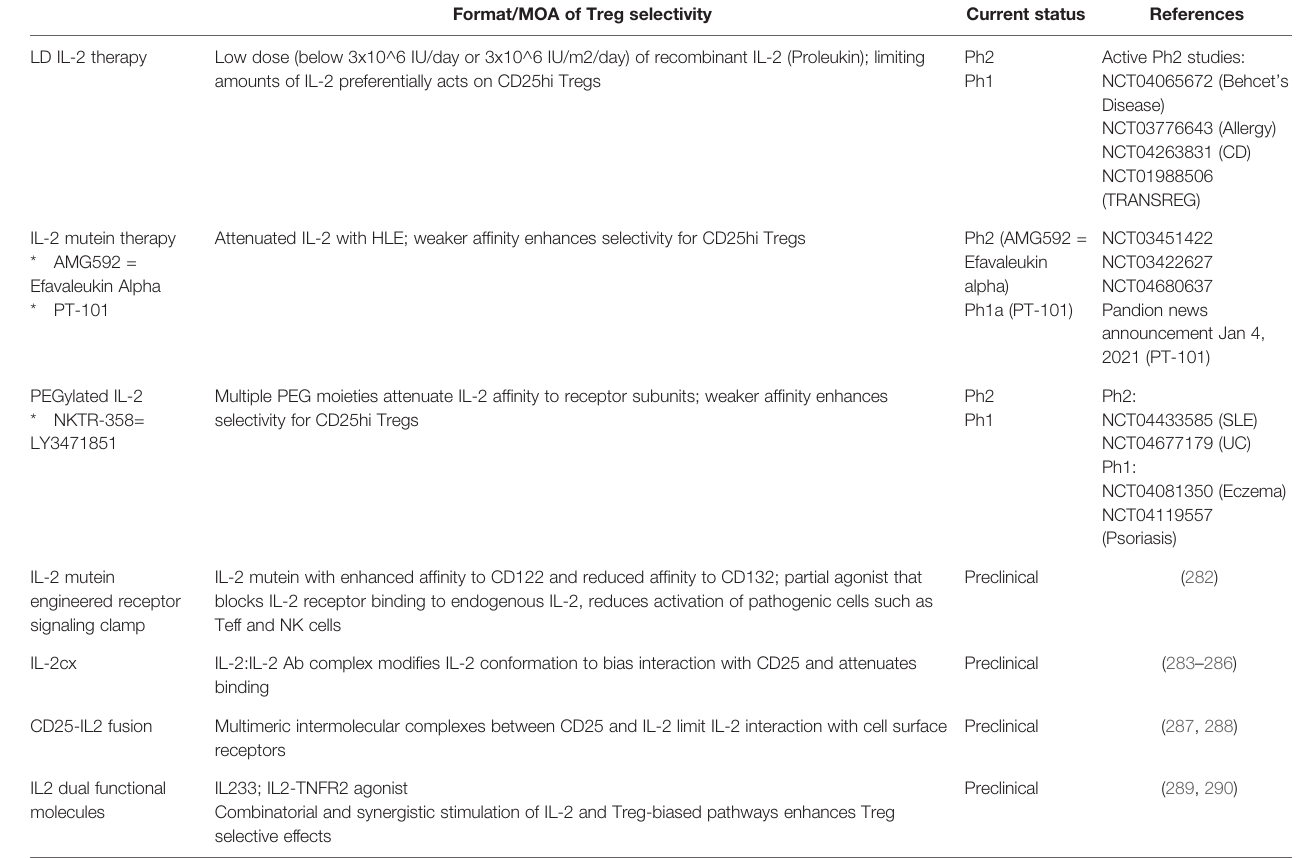
TABLE 7 | Summary of IL-2 therapies in